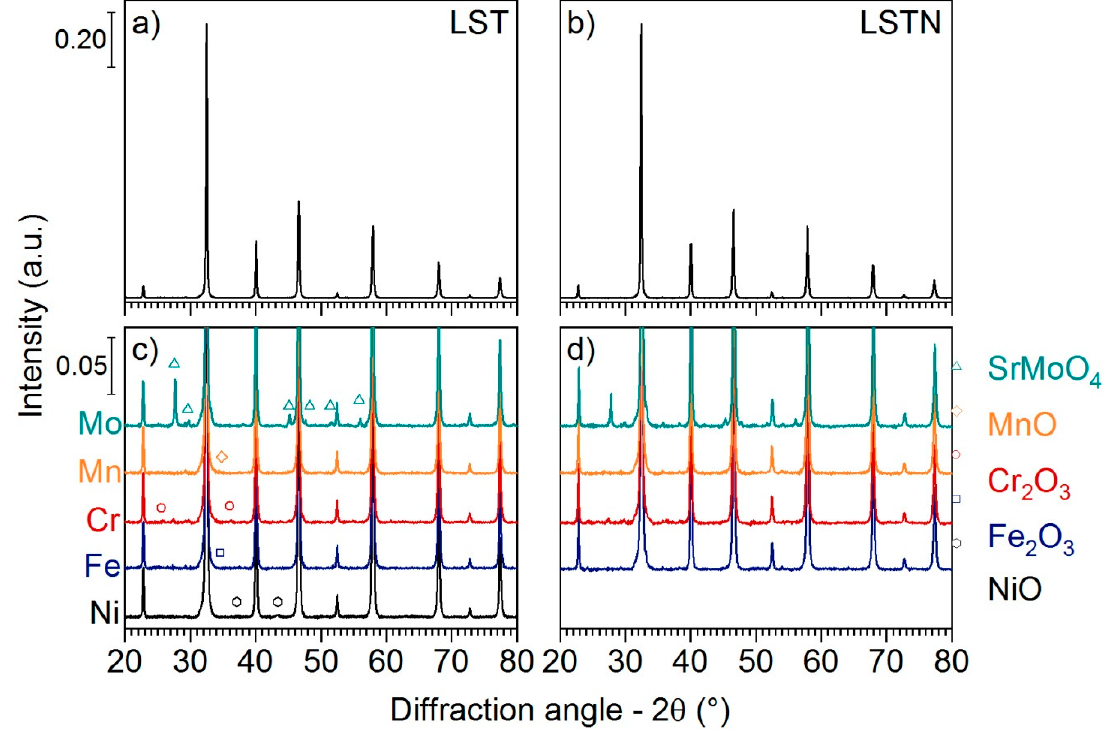
Figure 1. Powder XRD patterns of ( a ) La 0.3 Sr 0.55 TiO 3 ± δ (LST), ( b ) La 0.3 Sr 0.55 Ti 0.95 Ni 0.05 O 3 ± δ (LSTN), ( c ) LST-5Me (Me = Mo, Mn, Cr, Fe, Ni) and ( d ) LSTN-5Me (Me = Mo, Mn, Cr and Fe). Markers indicate the presence of metal oxide phases after impregnation. Note that the intensity of the diffractograms in ( c ) and ( d ) is magnified (5 × ) with respect to ( a ) and ( b ).